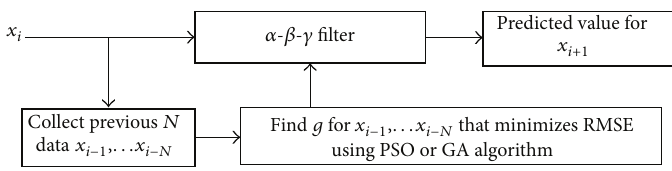
Figure 6: Block diagram of adaptive 𝛼 - 𝛽 - 𝛾